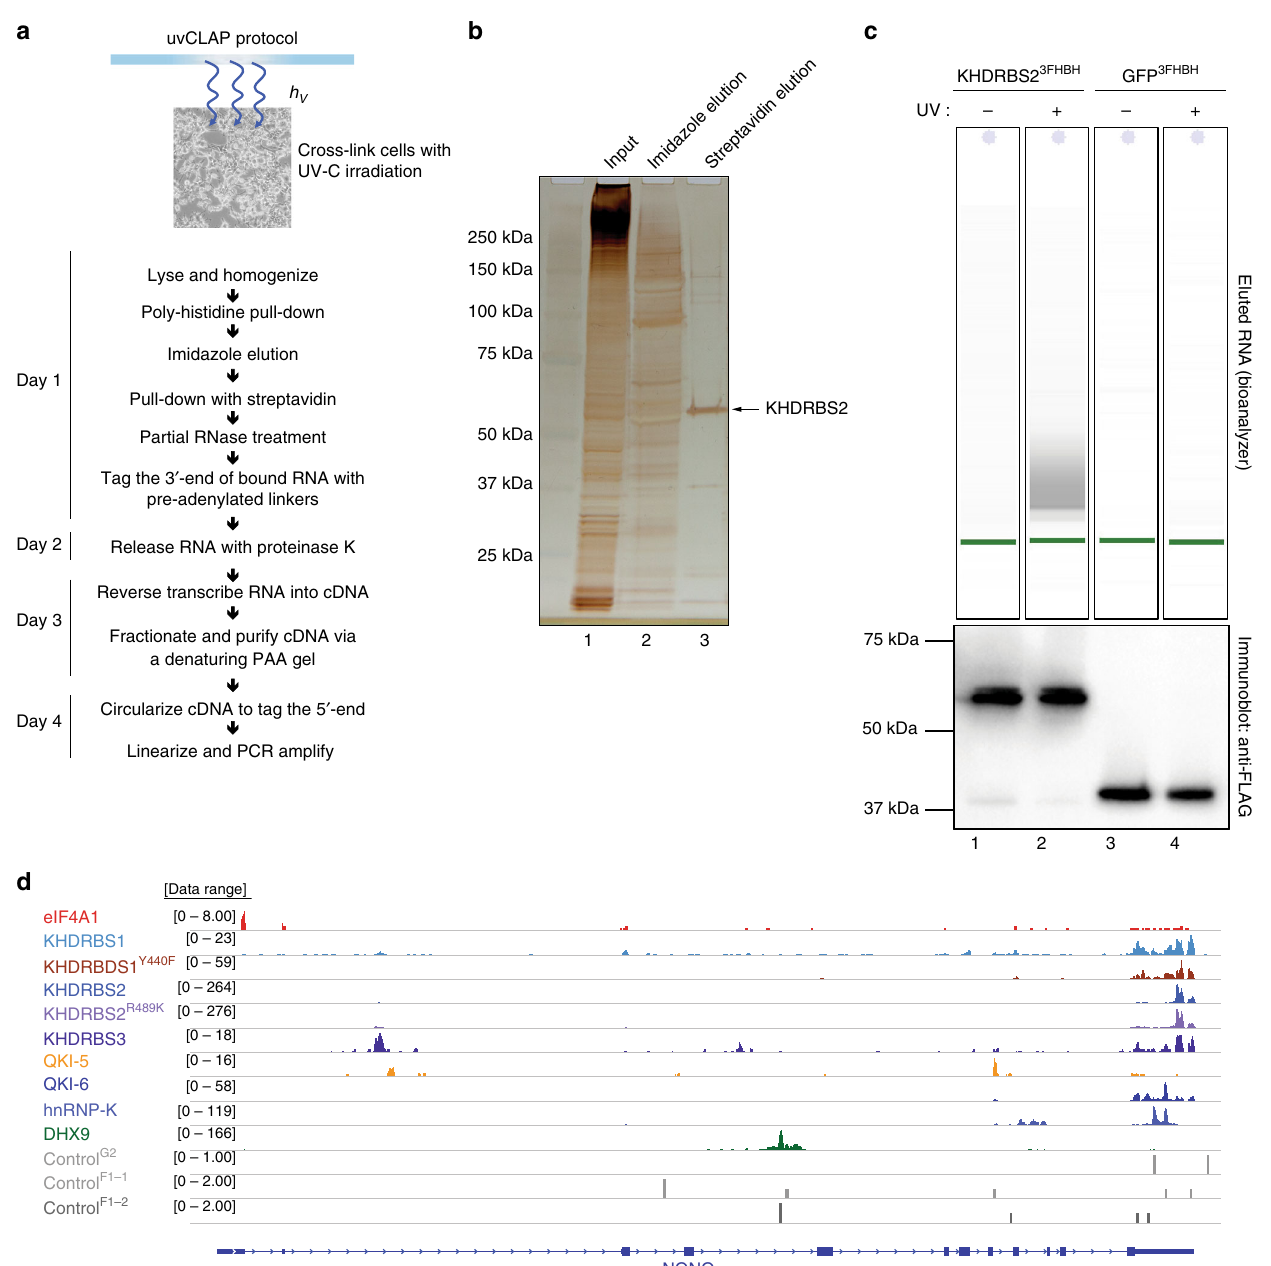
Fig. 1 uvCLAP identi fi es in vivo targets of RBPs. a Experimental work fl ow of uvCLAP, starting from cells-on-plates to the generation of sequencing libraries. b Silver staining analysis of tandem af fi nity puri fi ed of 3xFLAG-HBH tagged KHDRBS2 under the highly stringent uvCLAP conditions (see Methods). Lane 1: initial lysate, lane 2: eluate after the fi rst step of puri fi cation, lane 3: fi nal eluate from streptavidin beads. c Bioanalyzer traces of RNA puri fi ed from non- crosslinked KHDRBS2 3FHBH (lane 1), UV-crosslinked KHDRBS2 3FHBH (lane 2), non-crosslinked GFP 3FHBH (lane 3) and UV-crosslinked GFP 3FHBH (lane 4) lysates at the end uvCLAP puri fi cation as in a and b (top). Eluted protein from the same samples, analyzed in parallel via immunoblotting with anti-FLAG antibodies (bottom). Also see Supplementary Fig. 2b for a comparison to FLAG-only puri fi cations. d IGV (Integrative Genomics Viewer) snapshot of uvCLAP pro fi les for eIF4A1, KHDRBS1, KHDRBS1 Y440F , KHDRBS2, KHDRBS2 R489K , KHDRBS3, QKI-5, QKI-6, hnRNPK and DHX9 on NONO gene. Biological replicates are merged for this representation, data range represents the coverage of uvCLAP reads. Only plus strand data is represented for visual